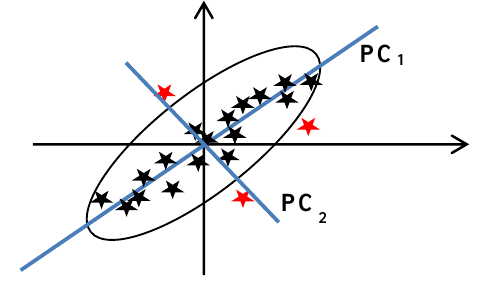
Figure 1. The 2D distribution of values around their principal